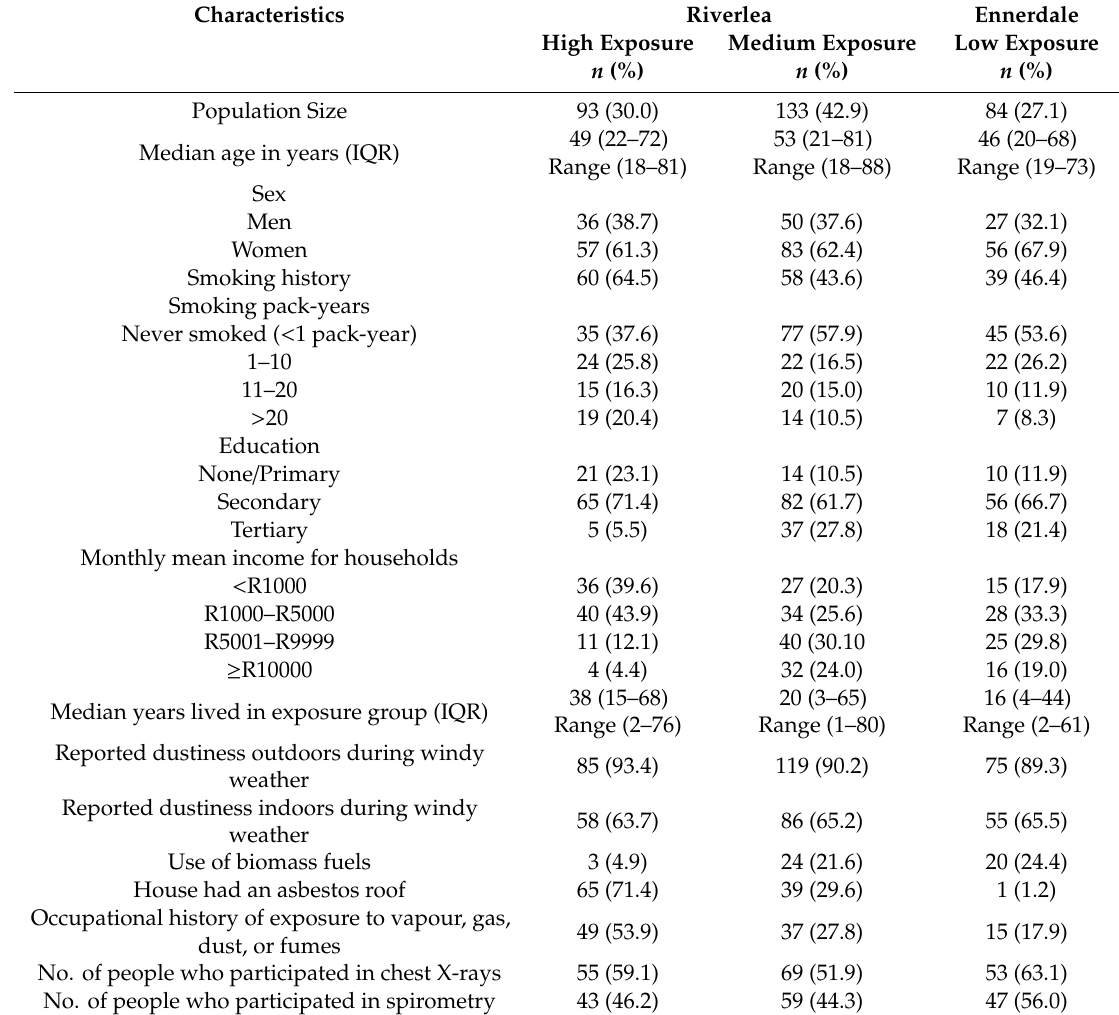
Table 2. Characteristics and investigations of 310 study participants by exposure